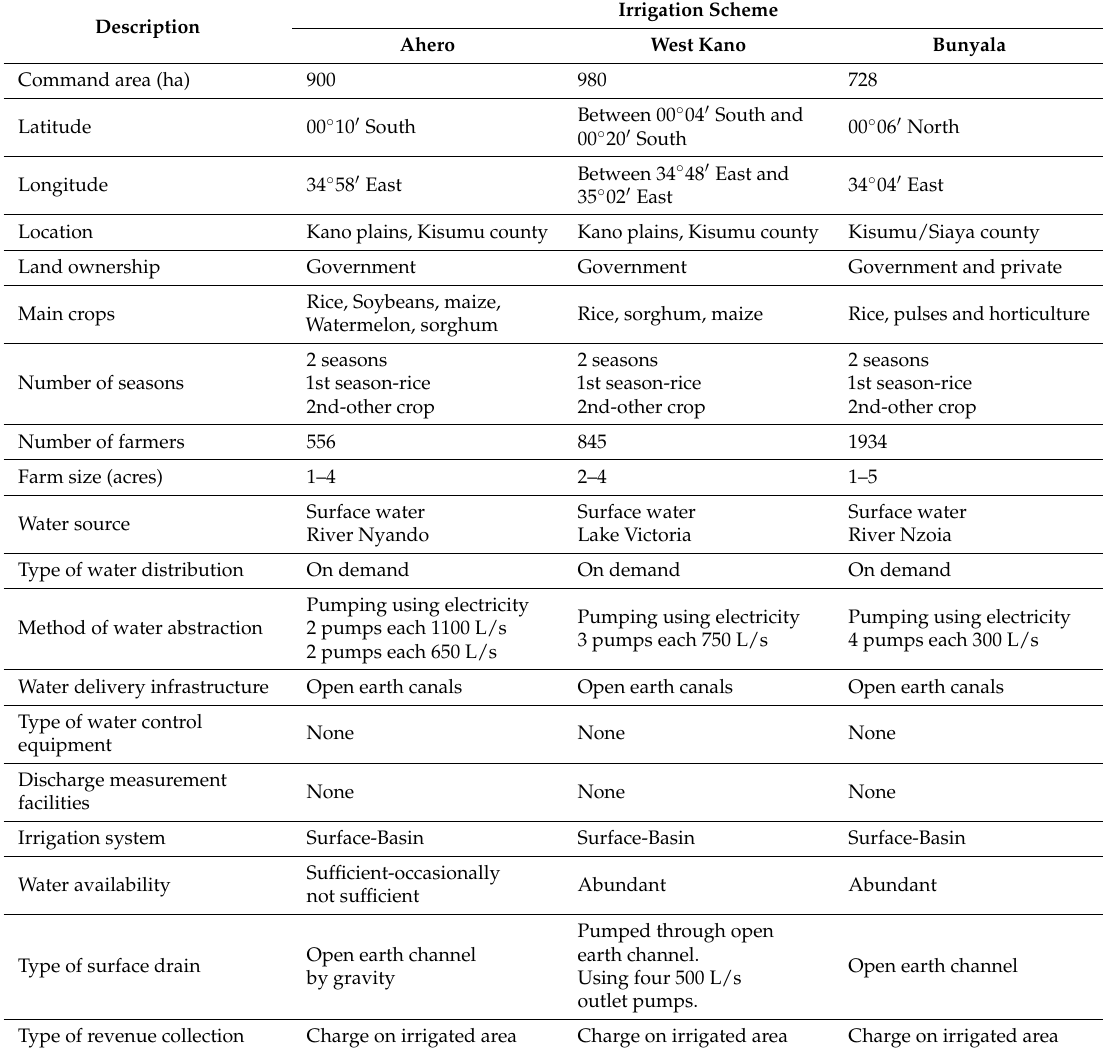
Table 2. Main characteristics of irrigation schemes benchmarked in western